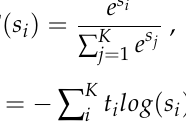
Figure 5. Ultrasonic signals obtained from the three different surface conditions. The signals were cropped to 5000 sampling numbers and were plotted to overlap with each other.